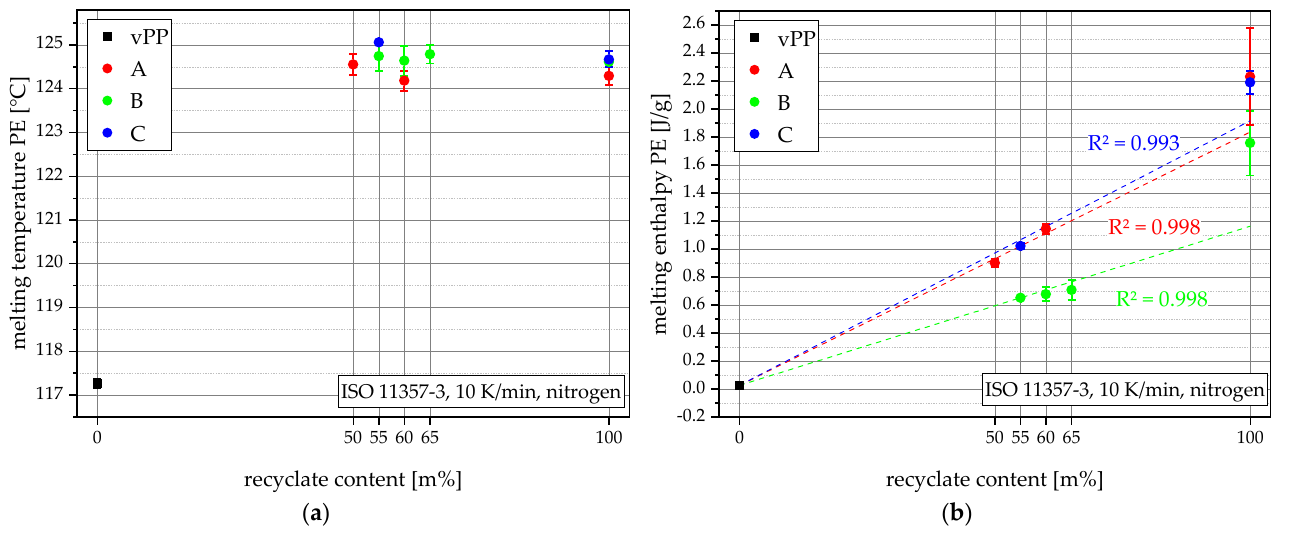
Figure 4. PE melting temperatures ( a ), and PE melting enthalpies ( b ) of all materials.